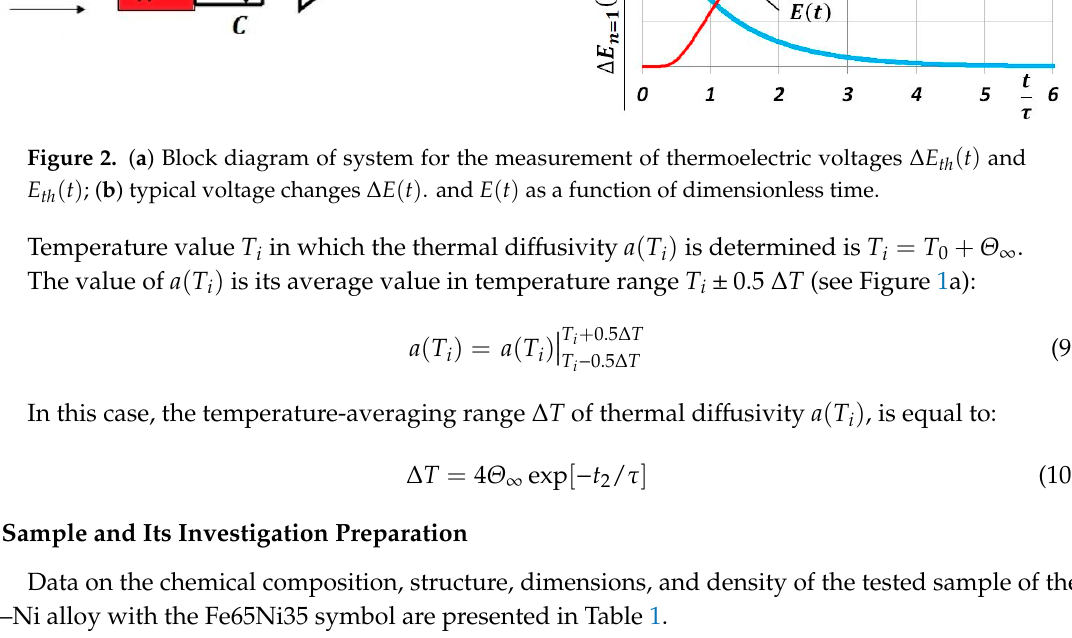
Table 1. Basic data of examined sample.